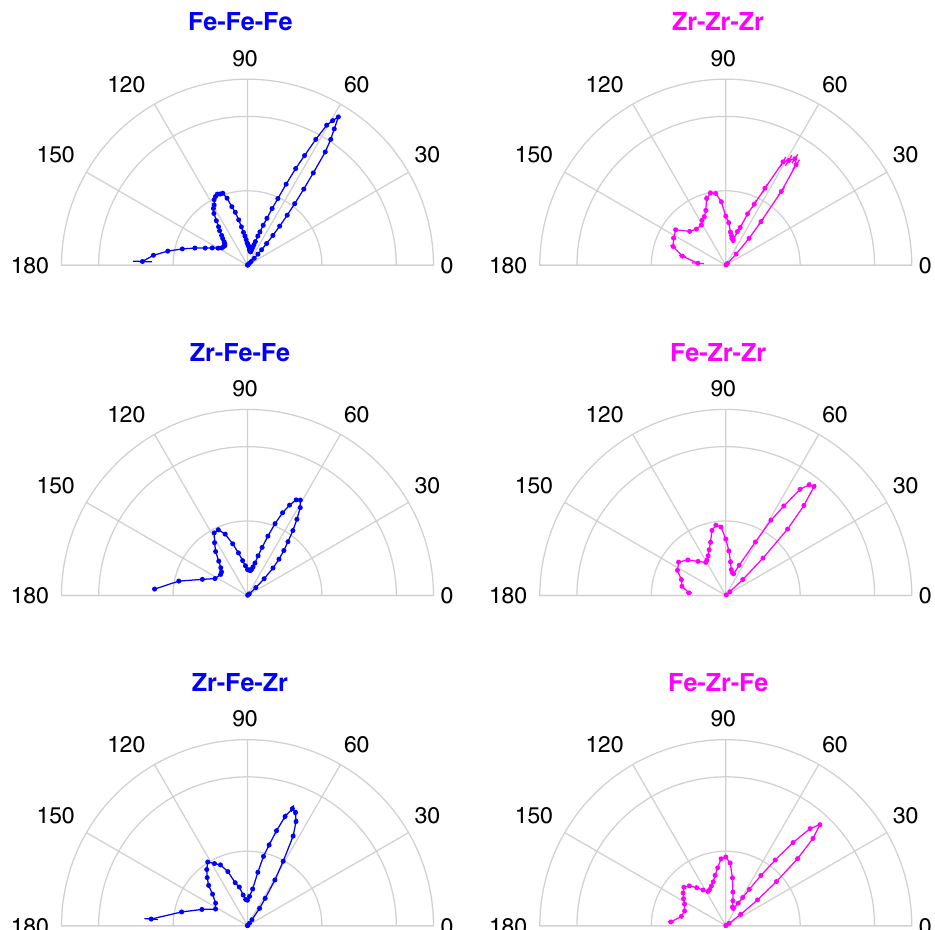
Figure 4. Polar plots of the partial angular distribution functions obtained from the simulated atomic positions for atoms belonging to the first shell around the central atom. These plots look quite similar for all compositions, but are only shown here for Fe 0.80 Zr 0.20 due to the better statistics for Zr in that case. Error bars are plotted, but are generally smaller than the size of the data points. The position of the cut-off for the first shell is indicated as a gray line for each partial radial distribution function in Fig.